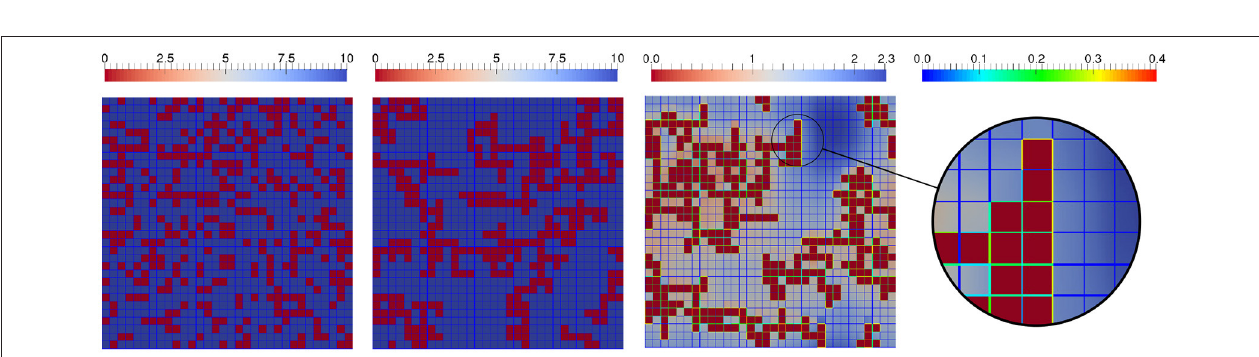
FIGURE 10 | Aerobic bacteria in fluid phase combined with solid restructuring and gas reorganization: The scale depicts the concentration of a nutrient. Thus, solid cells are red, fluid cells are violet to dark blue, and gas cells are pale blue to white in the right picture.